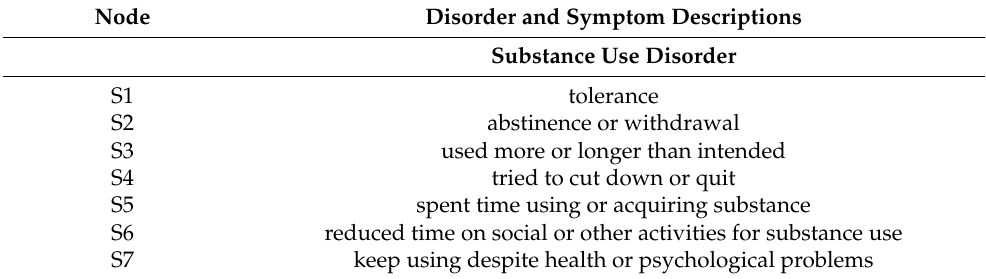
Table 1. Legend of symptom descriptions to identify